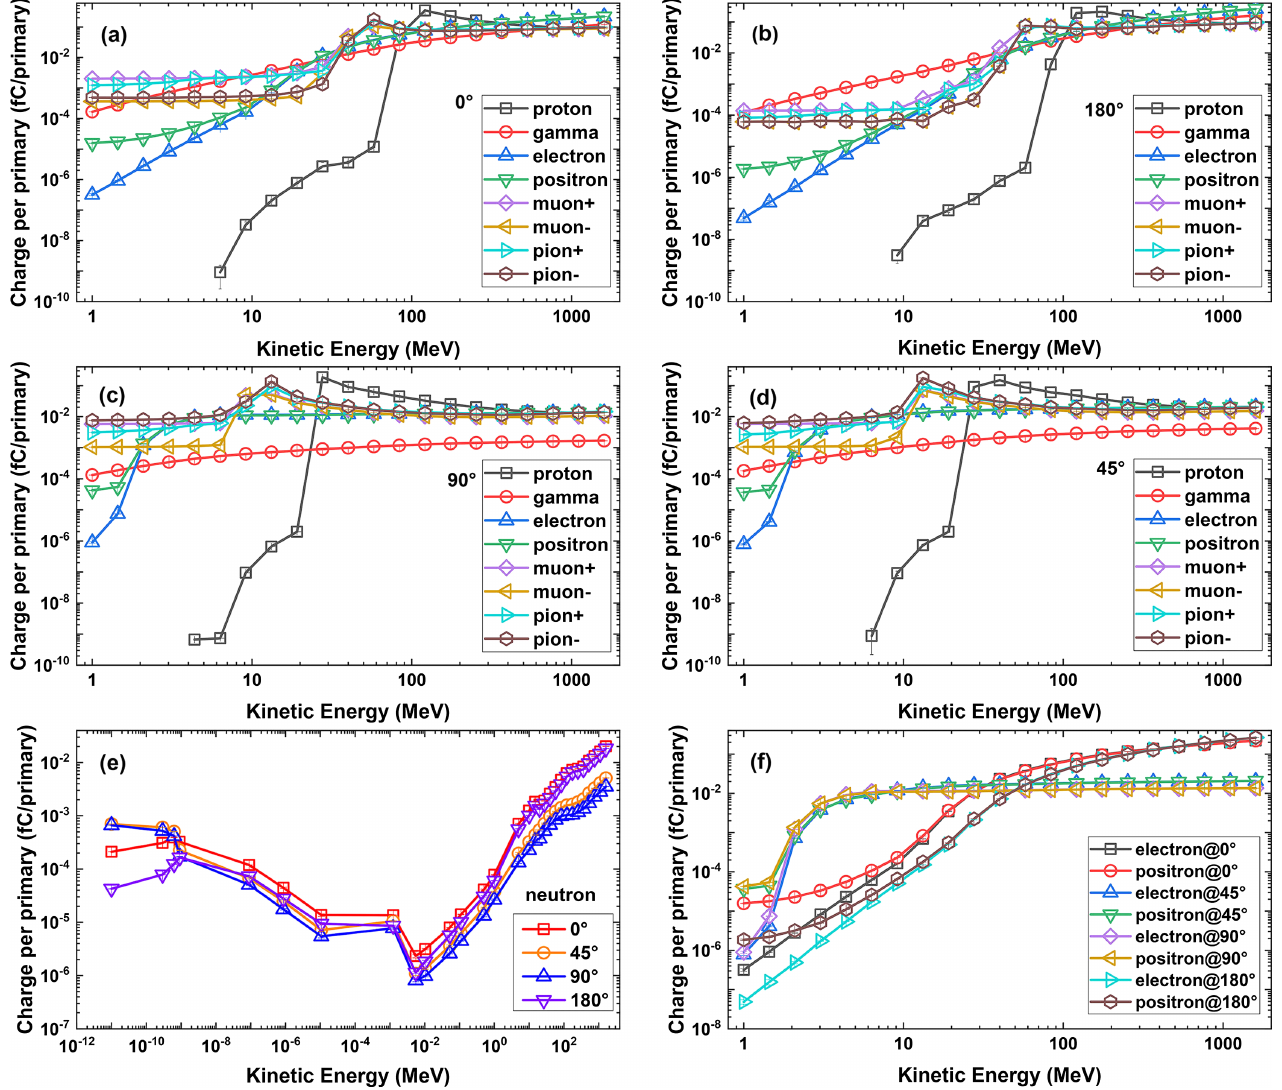
FIG. 10. Response functions for particles with different energies and angles. (a) 0°, (b) 180°, (c) 90°, (d) 45°, (e) neutron response functions in the range of 10 − 11 MeV to 1.6 GeV, and (f) enlarged view of e (cid:2) response